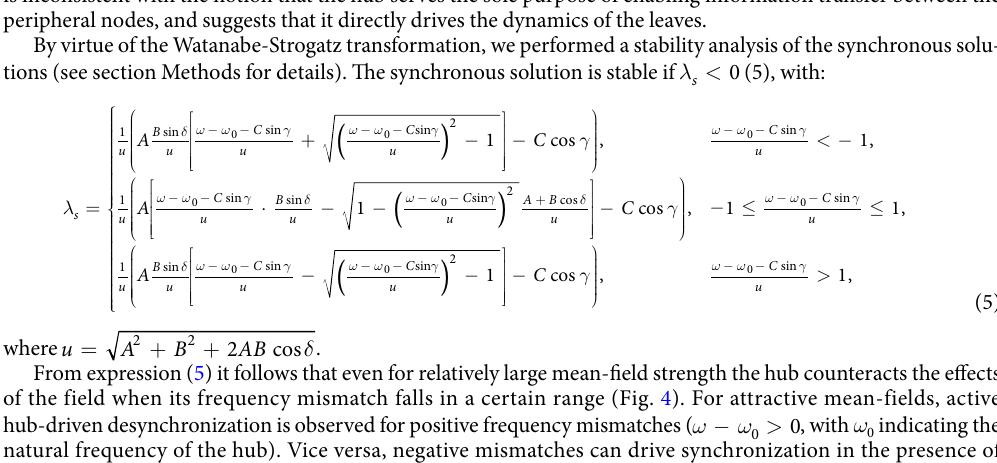
, with ω 0 indicating the 0